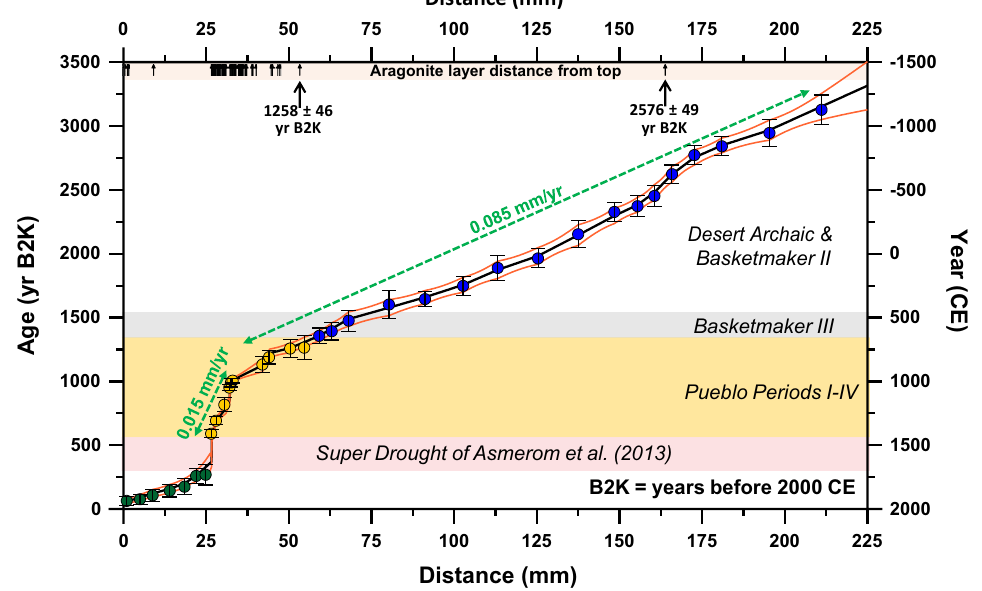
Figure 2. Stalagmite HC-1 high-resolution chronology consists of 34 uranium-series dates. Three intervals of growth are apparent, and compared with cultural periods, the most obvious association is the interval of slow stalagmite growth that takes place coincident with the Pueblo cultural stages. The age model 2σ uncertainty envelope shown as orange curves was generated using COPRA 23 . The symbols for aragonite layers (small black arrows) are only tied to distance